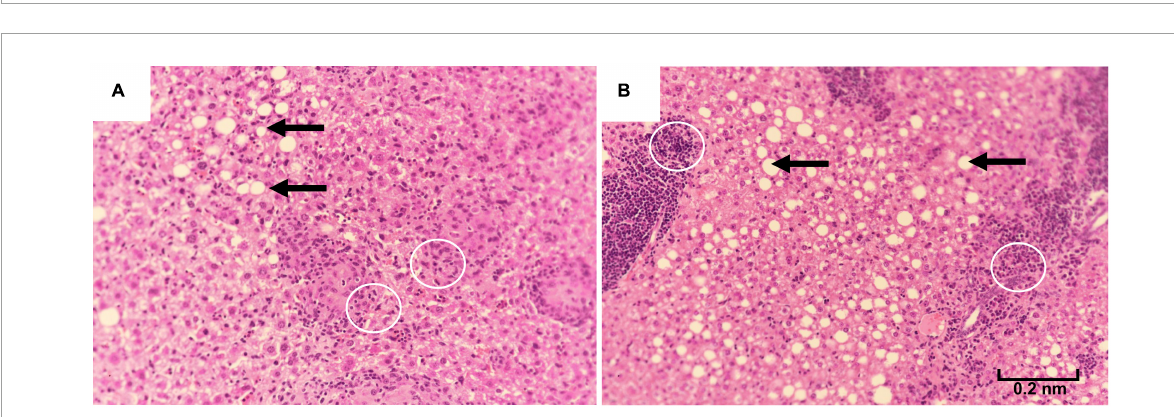
FIGURE5 Liver histopathology of male C57BL/6N mice fed different diets at time of sacrifice, assessed using hematoxylin-eosin staining of liver samples (magnification 200 × ). (A) A total of 10% kcal, (B) 25% kcal. Both groups showed fatty lipid droplets (arrows). Prescence of Kupffer cells (white circles) were also